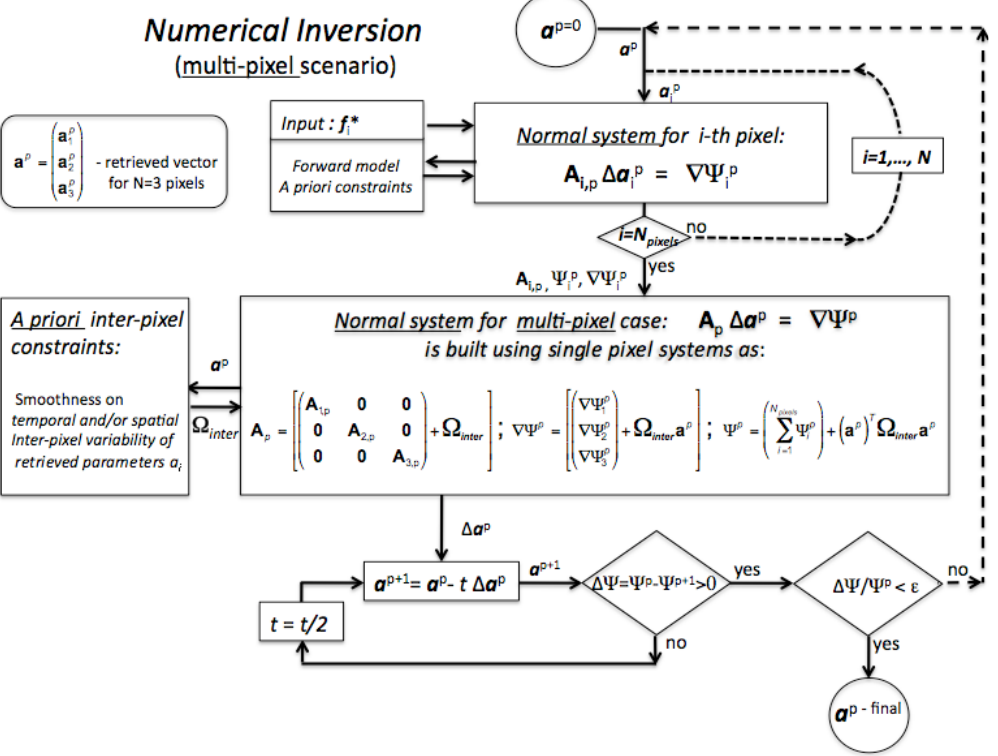
Fig. 7. The diagram illustrating the numerical inversion data flow implemented for the simultaneous retrieval of aerosol properties over multiple